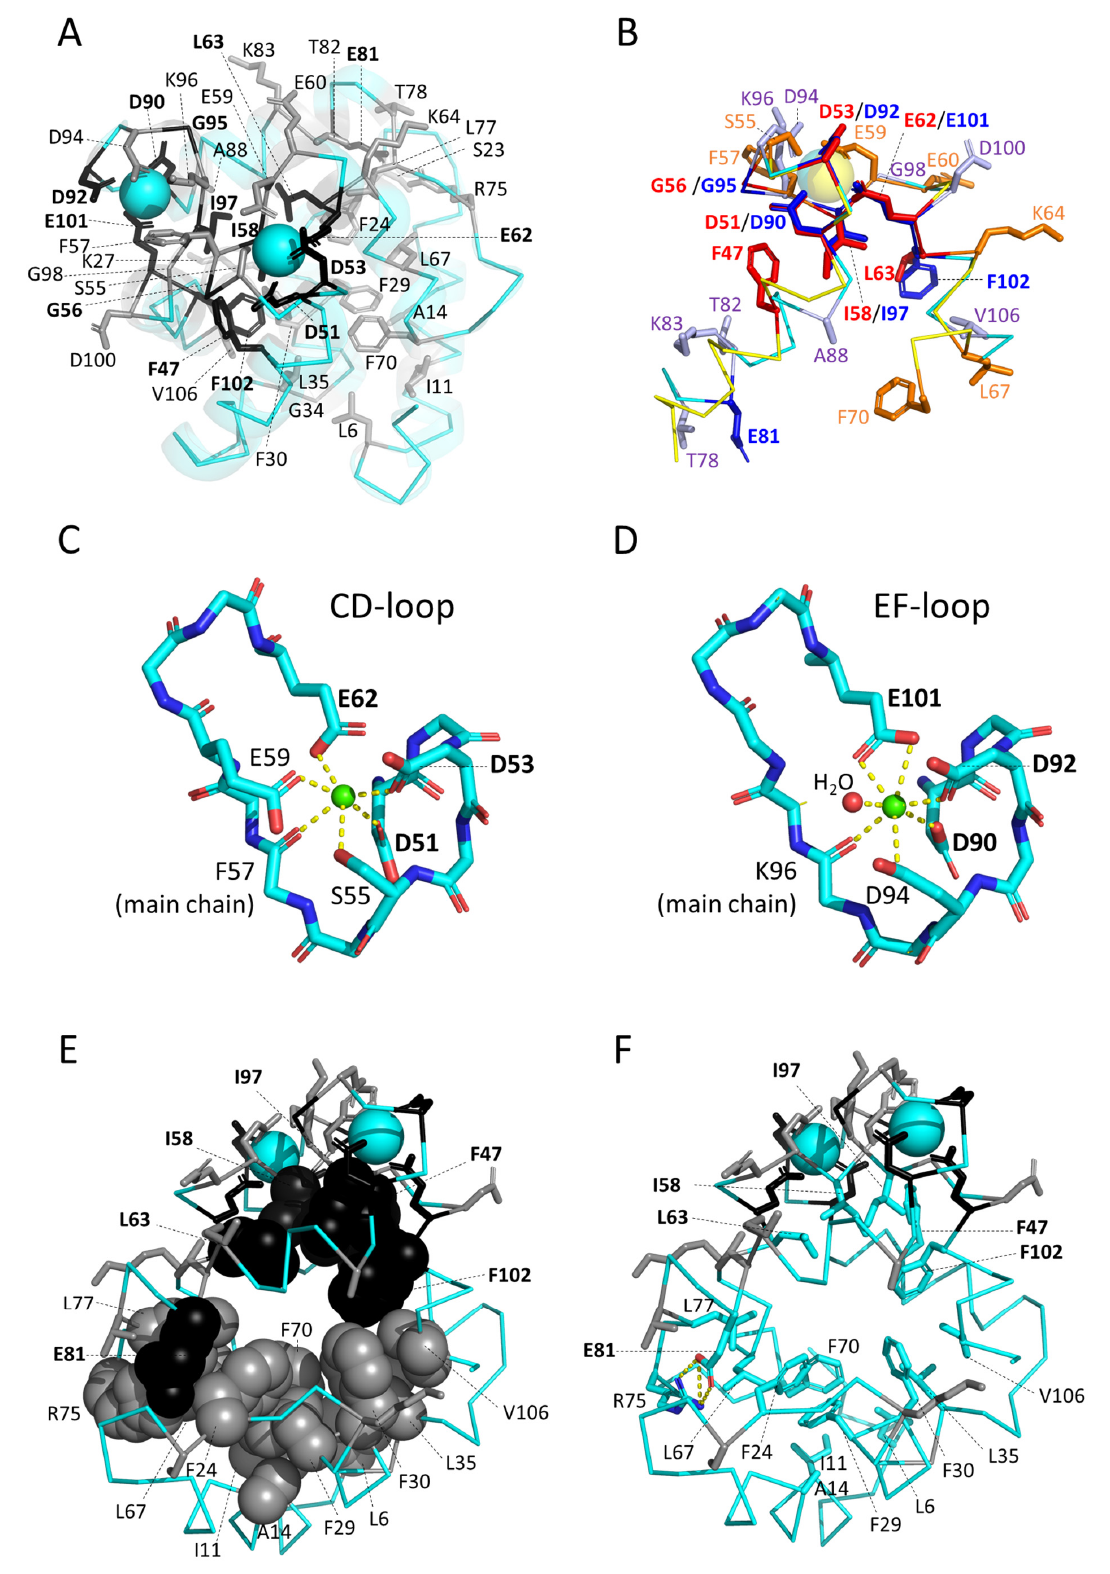
Figure 5. Structural positions of residues that are conserved in EF-hand domain family molecules and parvalbumins. ( A ) The structure of common carp pvalb4 (Chr.A3) (PDB accession 4CPV) with highlighting in sticks format the residues conserved in EF-hand domain family molecules (black)